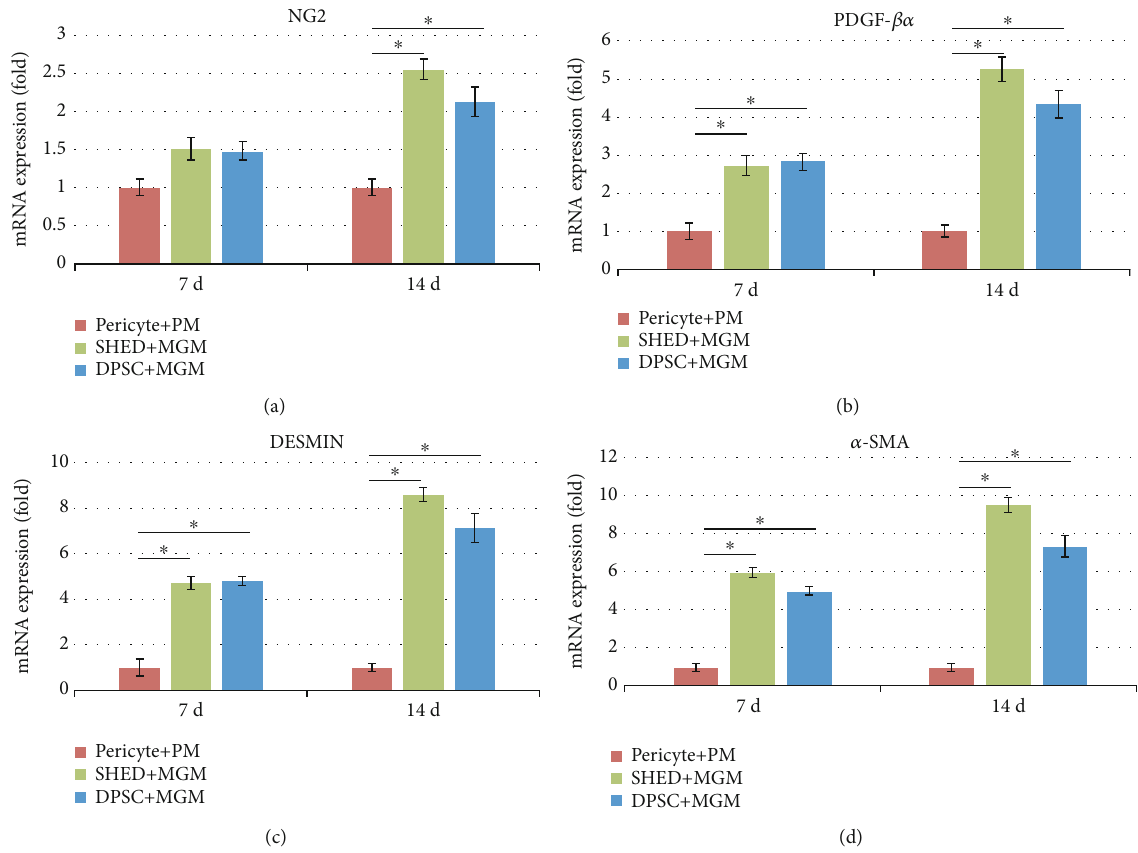
Figure 6: The expression of pericyte-speci fi c cell surface markers after culture in Pericyte Medium (PM) and Melanocyte Growth Medium (MGM)for 14d. (a) Stem cells from human exfoliated deciduous teeth (SHEDs) (NG2+, 23.3%; DESMIN+, 83.7%; PDGFR- β , 93.3%; α -SMA, 93.3%). (b) Pericytes (NG2+,74.3%; DESMIN+,67.8%; PDGF- β , 85.6%; α -SMA, 92.3%). (c) Postnatal human dental pulp stem cells (DPSCs) (NG2+,15.1%; DESMIN+, 58.4%; PDGFR- β , 80.6%; α -SMA,